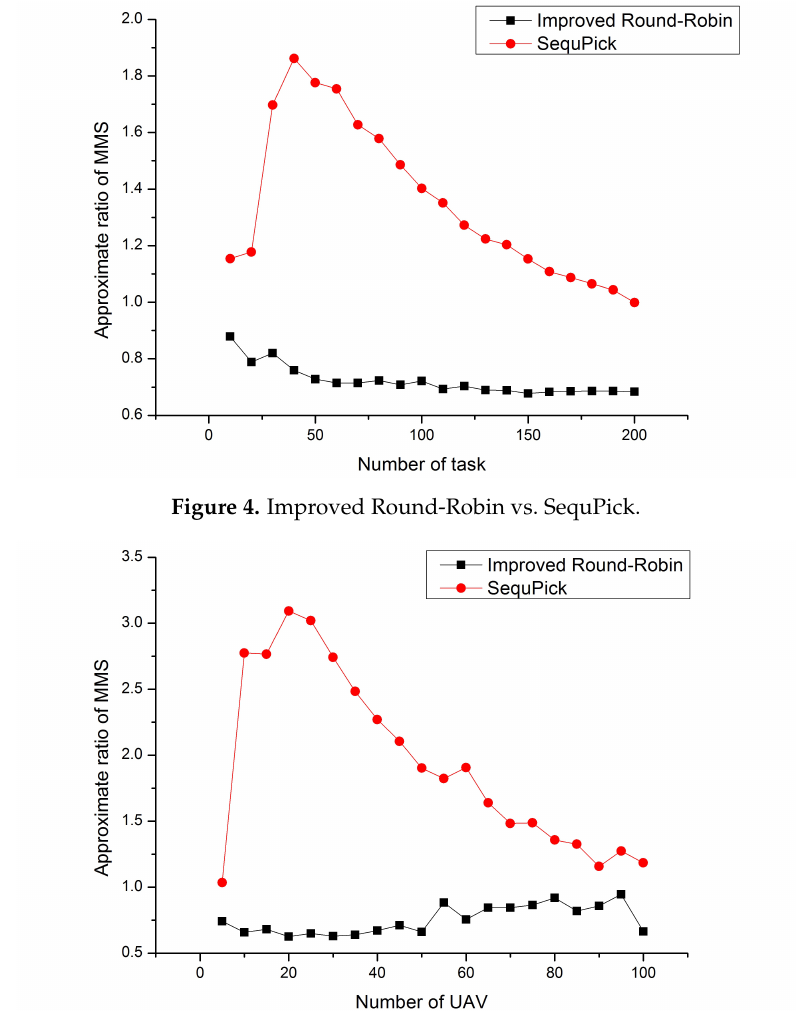
Figure 5. Improved Round-Robin vs.